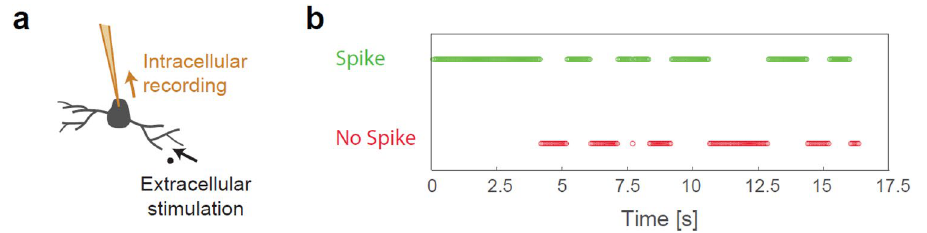
Figure 5. Experimental observation of a biological neuron with silencing periods that inspired ID-net. ( a ) Scheme of an in-vitro neuron in a synaptic blocked culture that was stimulated via one of its dendrites and recorded intracellularly. ( b ) Example of recorded neuronal responses, stimulated above-threshold at 20 Hz. The responses comprised time-lags of full responsiveness (segments of green circles) separated by silencing periods (segments of red